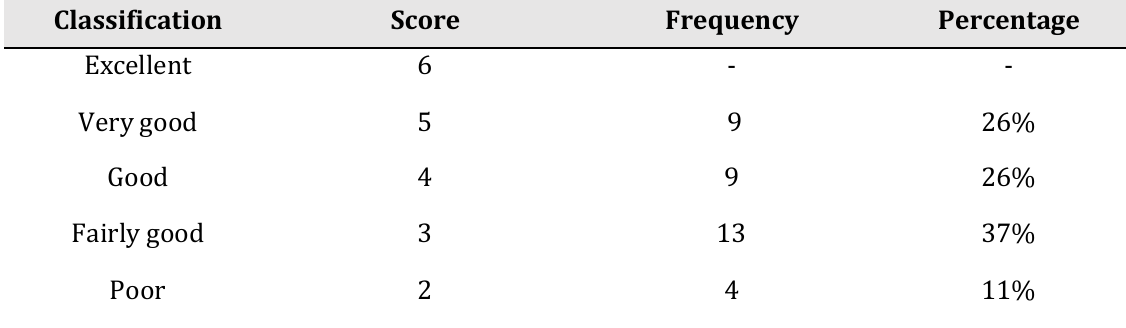
Table 13. rate percentage point of